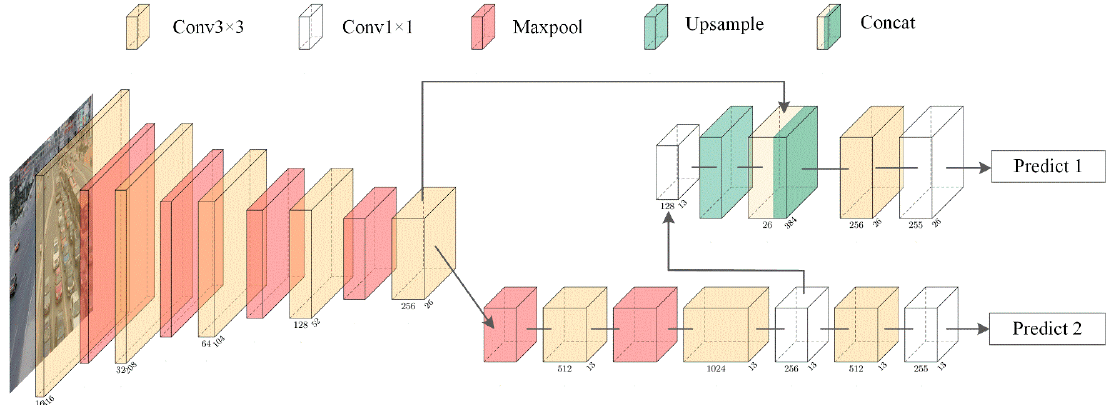
Figure 1. Network structure of